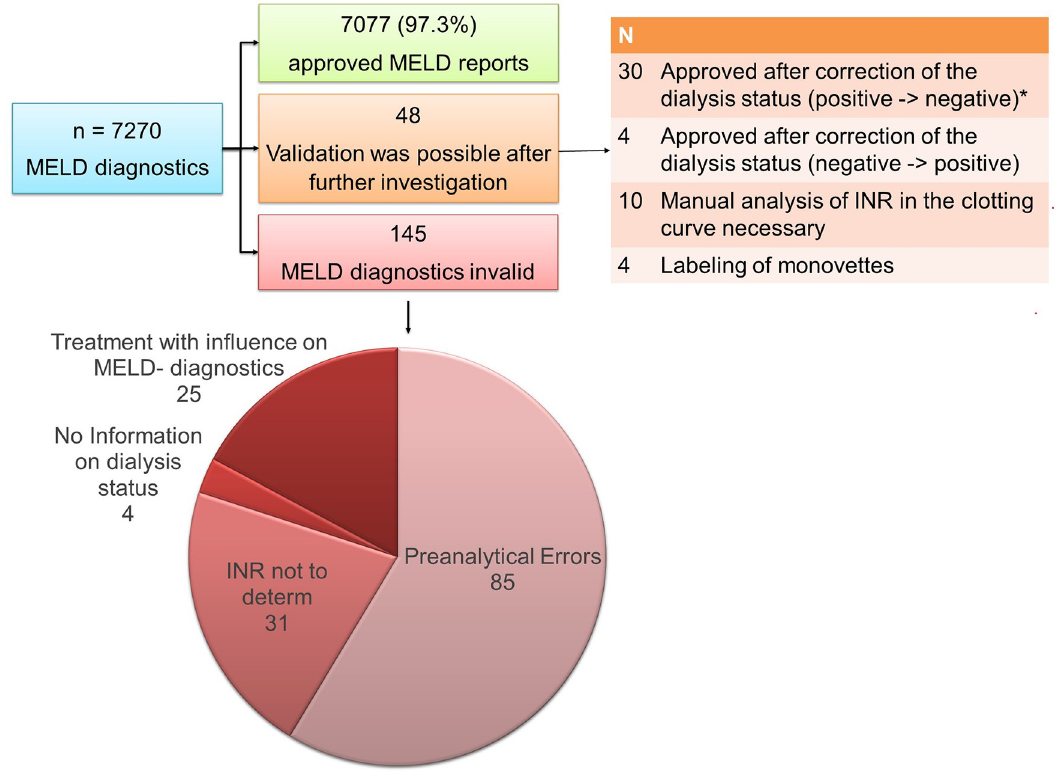
Only valid results that could be reported to the transplant organization are displayed.